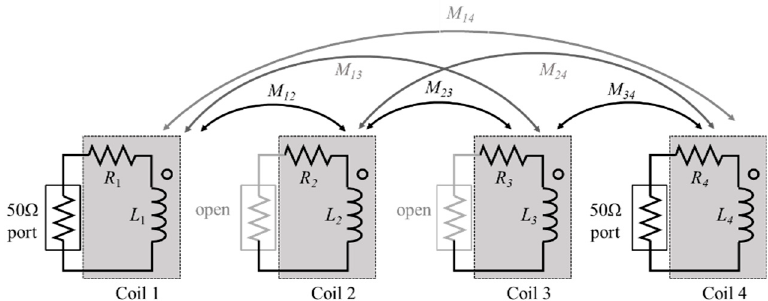
Figure 3. Circuit diagram for measuring coupling coefficient between coils 1 and 4 for four coils using a two-port vector network analyzer (VNA).